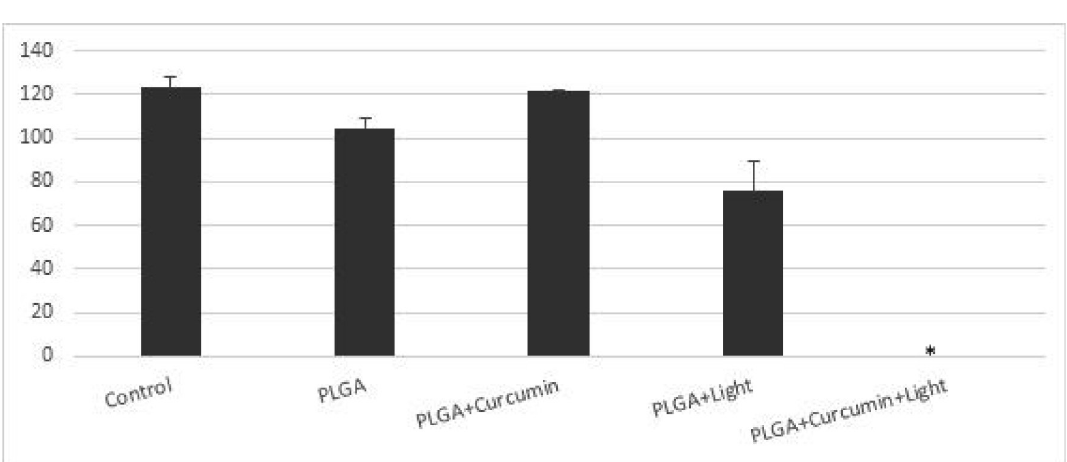
FIGURE 5 - Effects of antimicrobial photodynamic therapy (aPDT) with PLGA NPs against Staphylococcus epidermidis ATCC 12228 in each of the following treatment groups: control (no NPs and no light), PLGA (empty NPs without light), PLGA+ c urcumin (NPs without light), PLGA+light (empty NPs with light), and PLGA+curcumin+light (aPDT). S. epidermidis was cultivated in TSA (control). The treatments were performed at the exposure time of 4